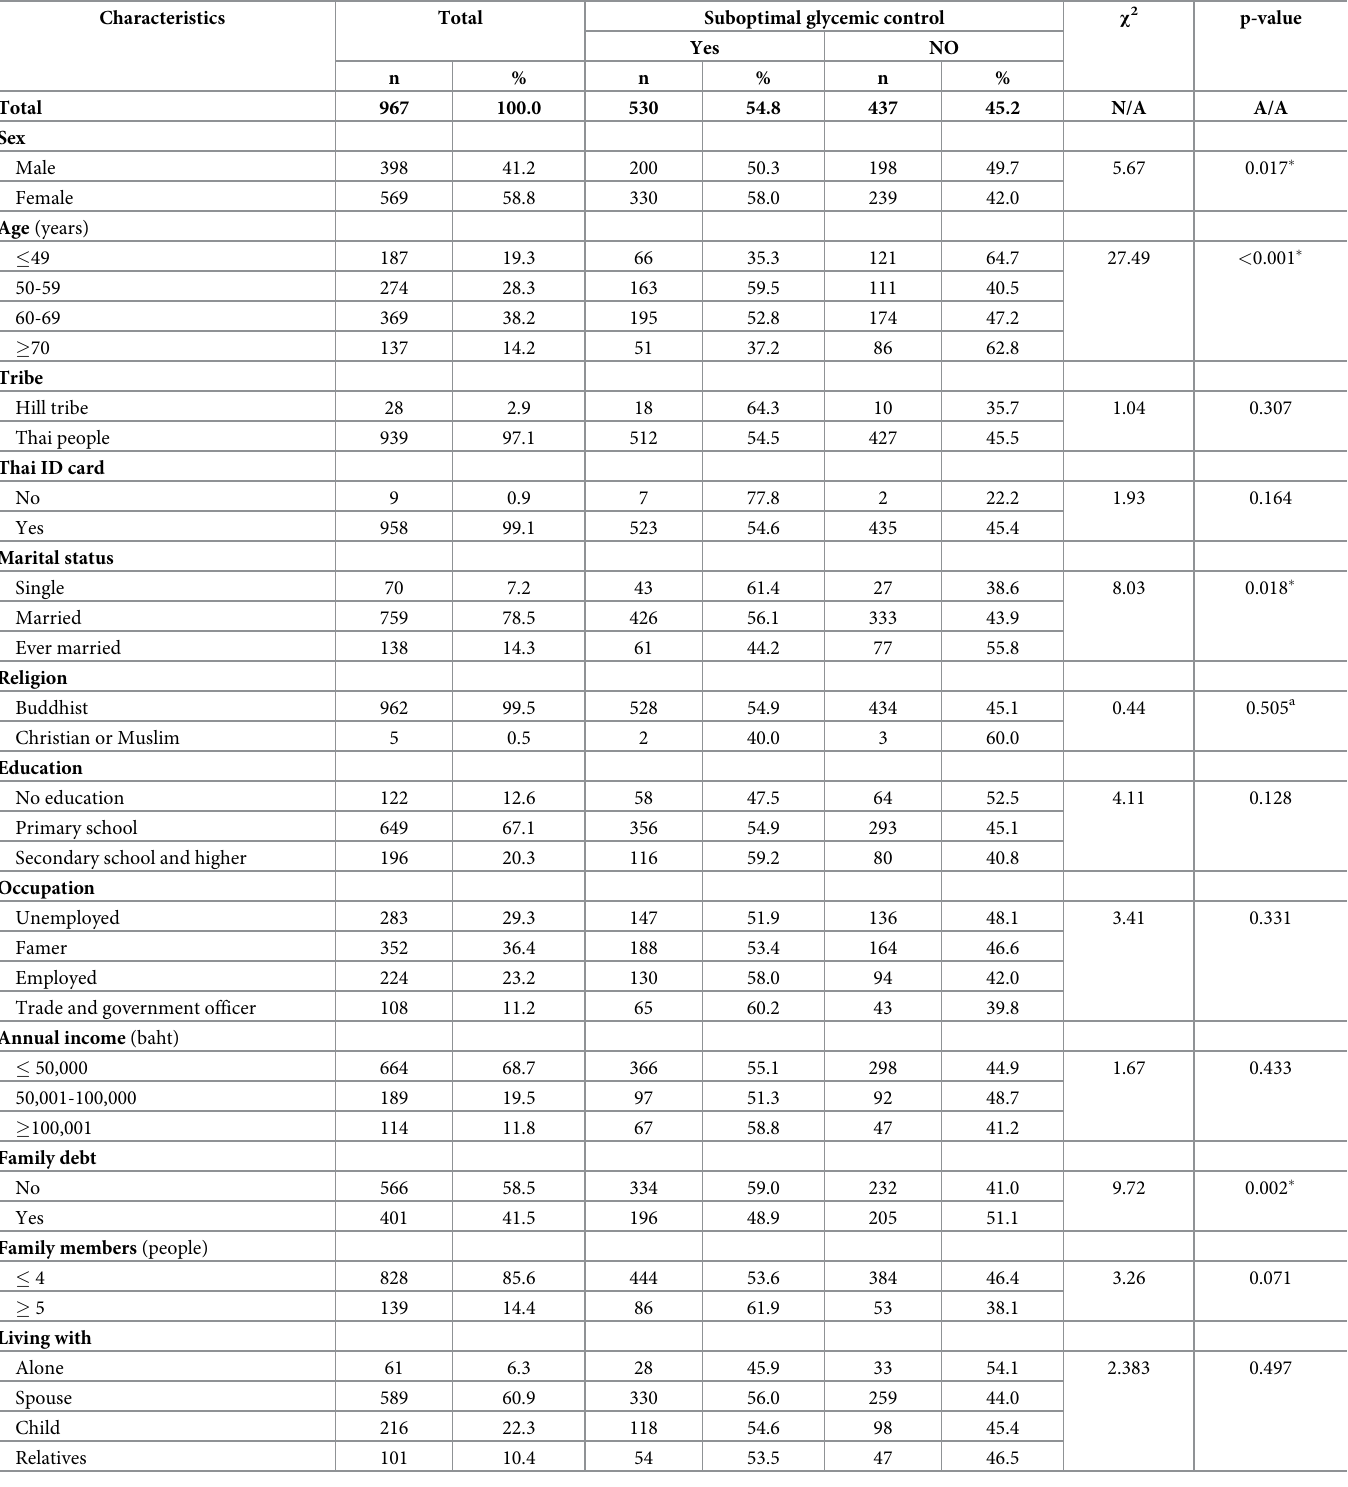
Table 1. General characteristics of